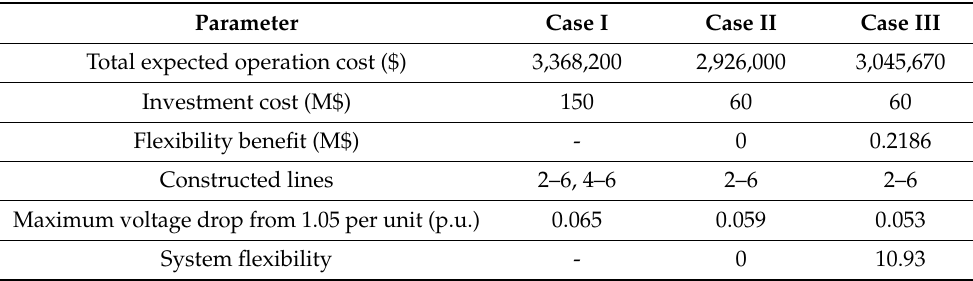
Table 7. The results of different methods of the proposed CNEP